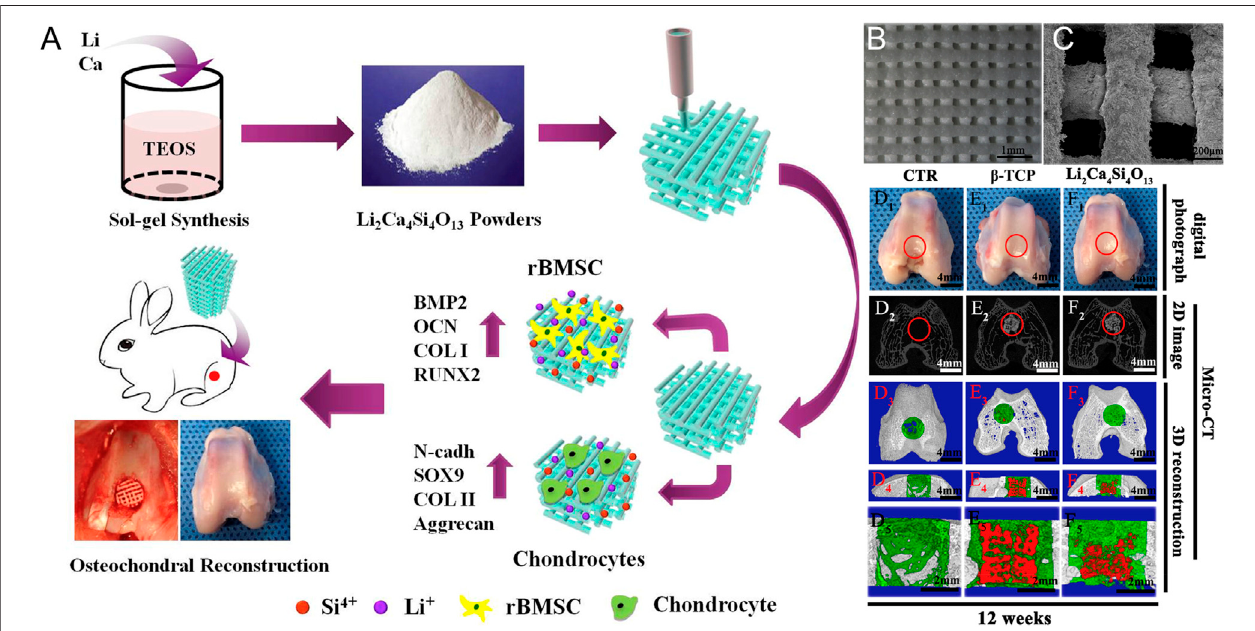
FIGURE6| 3Dprintingofalithium-calcium-silicatecrystalbioscaffoldwithdualbioactivitiesforosteochondralinterfacereconstruction. (A) Schematicillustrationof application of Li2Ca4Si4O13 scaffolds for osteochondral reconstruction; (B) SEM images of 3D-printed Li 2 Ca 4 Si 4 O 13 scaffolds after fabrication and (C) after soaking in the simulated body fl uids for 14 days; Macro-photographs showed the defects in the control group and the other two experimental groups ( D 1 : blank control without scaffolds, E 1 : pure β -TCP scaffolds, F 1 : Li 2 Ca 4 Si 4 O 13 scaffolds) at 12 weeks of post-surgery; (D 2 – F 2 ) showed 2D projection images of the three experimental groups at week 12; (D 3 – F 3 ) showed the transverse view of3D reconstruction images ofthe three experimental groups at week 12; (D 4 – F 4 ) showed the sagittalviewof 3D reconstruction images of the three experimental groups at week 12. Copyright 2019